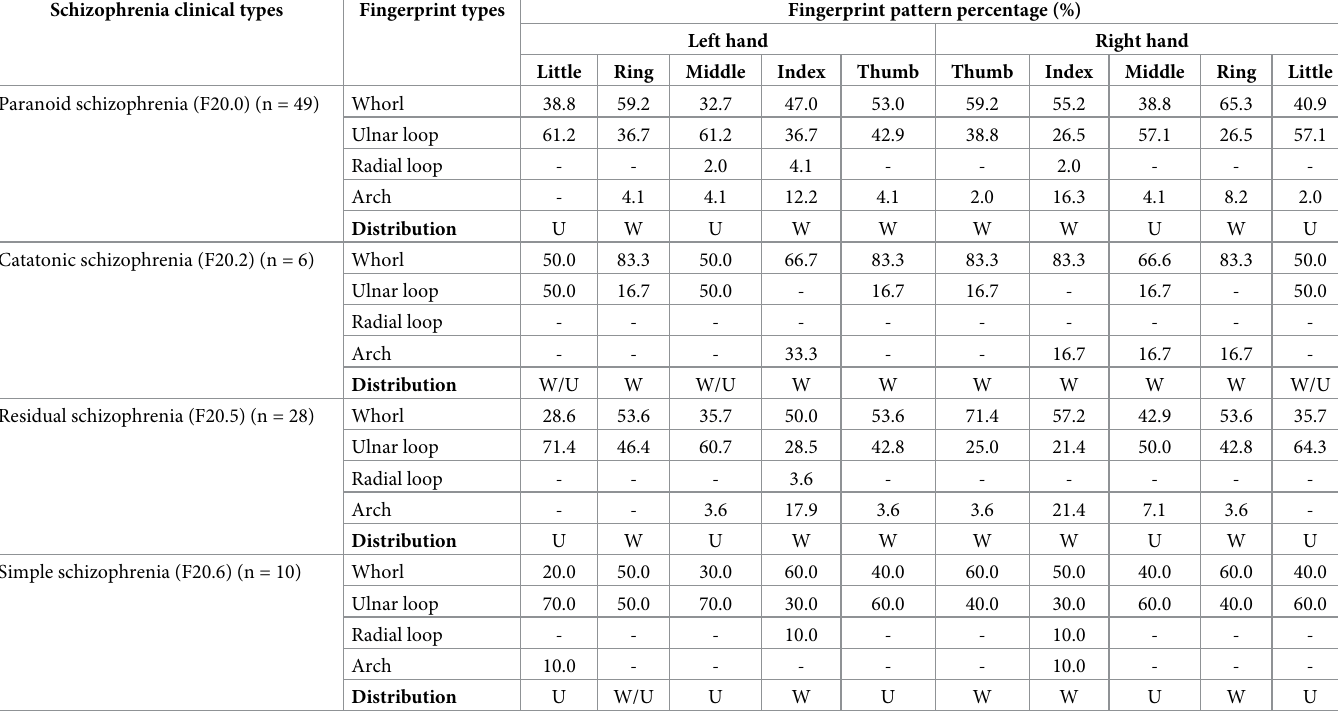
Table 3. Numbers and percentage of fingerprint pattern types by schizophrenia clinical types. Schizophrenia clinical types